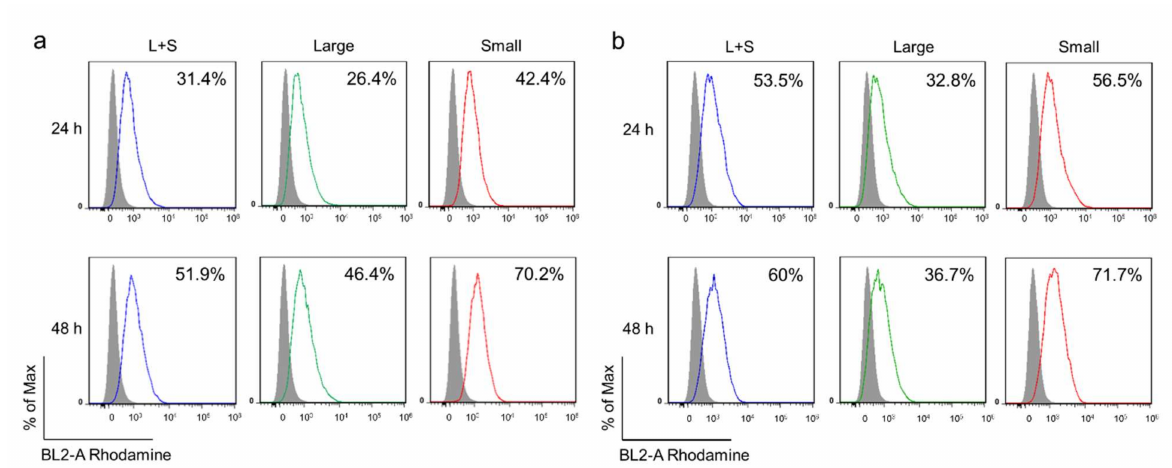
Figure 3. Internalization of FuNPs with different sizes into cancer cell lines. The percentage of 4T1 ( a ) and MDA-MB-231 cells ( b ) internalizing FuNPs from L+S, Large, and Small groups at 24 h and 48 h incubation was evaluated using flow